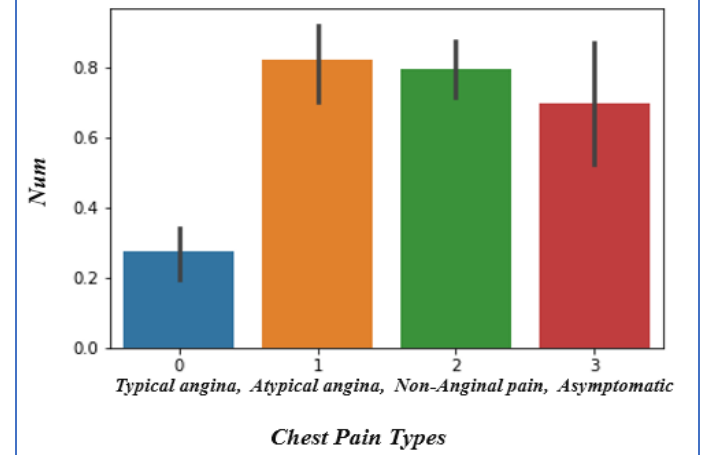
Figure 6. Chest pain vs. heart disease chances.